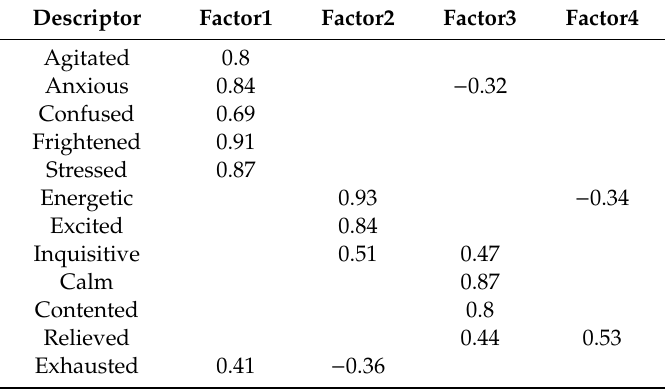
Table 1. Factor loadings of Factor Analysis of Fixed Term Descriptors applied by a panel of seven practitioners on 40 images of calves ( n = 10) during a calf roping event.